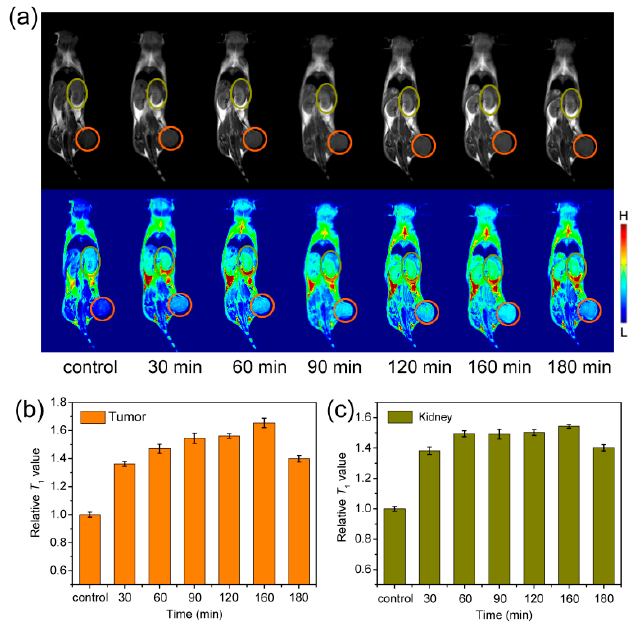
Figure 5. ( a ) T 1 -weighted MR images (B 0 = 1 T) of mice collected before (control group) and after intravenous injection of Fe 3 O 4 -PAA at time points of 30, 60, 90, 120, 160 and 180 min. The corresponding relative T 1 -weighted signals extracted from ( b ) tumor (orange circle) and ( c ) kidney (dark yellow circle) sites.